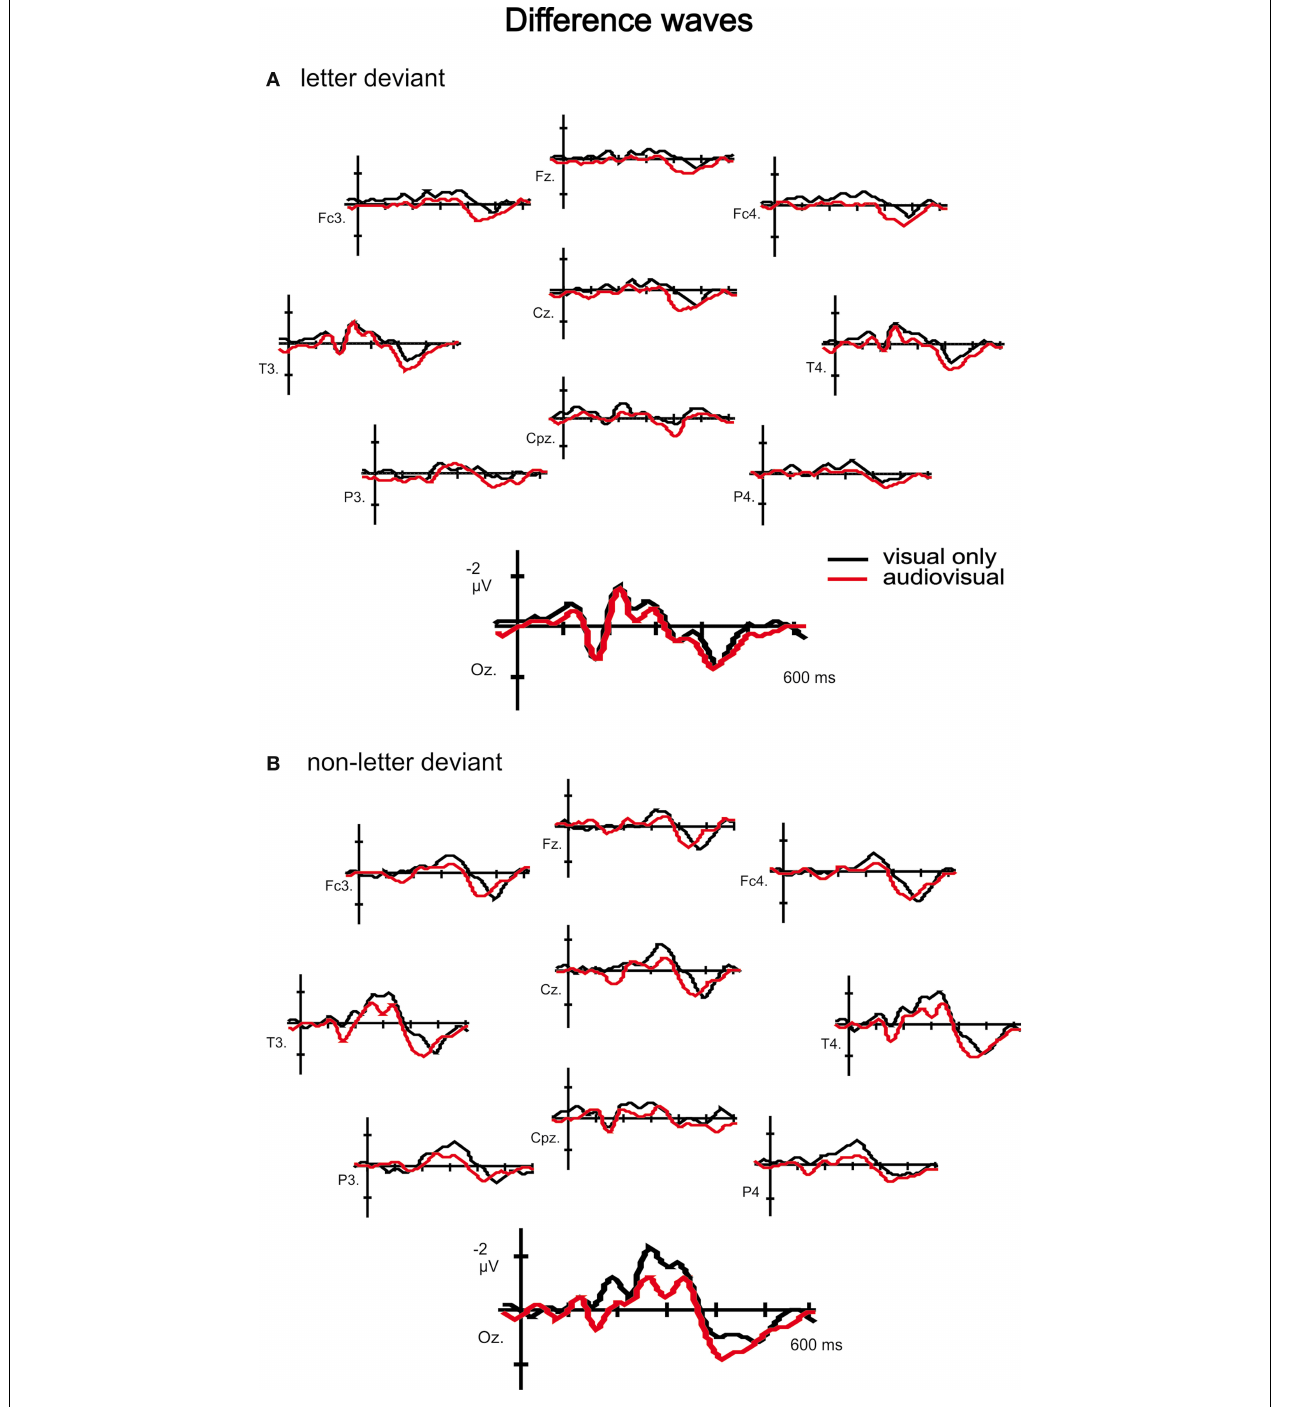
FIGURE 4 | Difference waves to letter (A) and non-letter deviants (B) observed at ten electrodes (Fz, Fc3, Fc4, Cz, T3, T4, Cpz, P3, P4 and Oz) in the visual experiment (black lines) and the audiovisual experiment (red lines). Only for the eight within-subject participants.